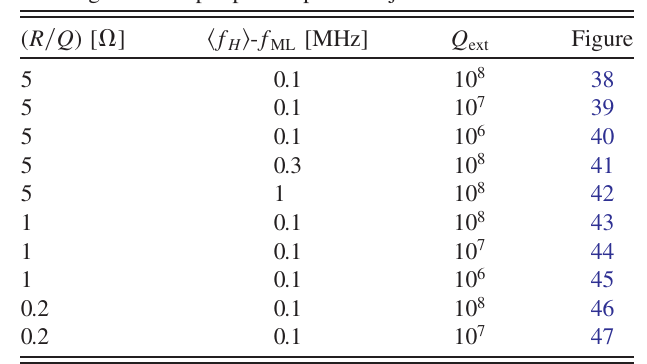
TABLE II. Different conditions for a h f H i close to a machine line ( f ML ¼ 6 =T ), ( R=Q ), and Q ext , and the figure number showing the example phase-space at ejection.